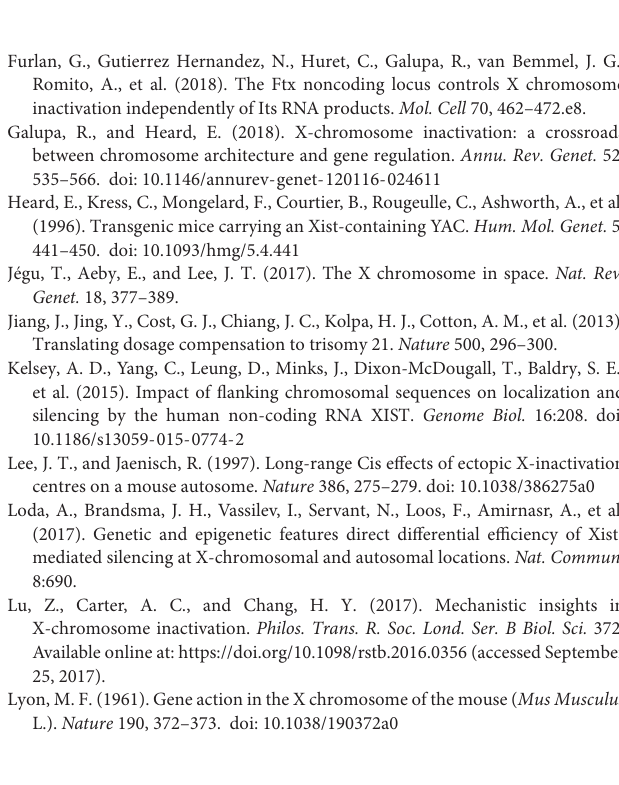
Supplementary Figure 1 | LINEs and SINEs in mouse and human chromosomes. LINEs density (left graph) and SINEs density (right graph) are plotted as the percentages of the sequence occupied in mouse chromosomes X (ChrX) and 1 (Chr 1), and in human chromosomes X (ChrX) and 21 (Chr21). Data were downloaded from UCSC genome browser with Repeat Masker for mm10 genome and hg38